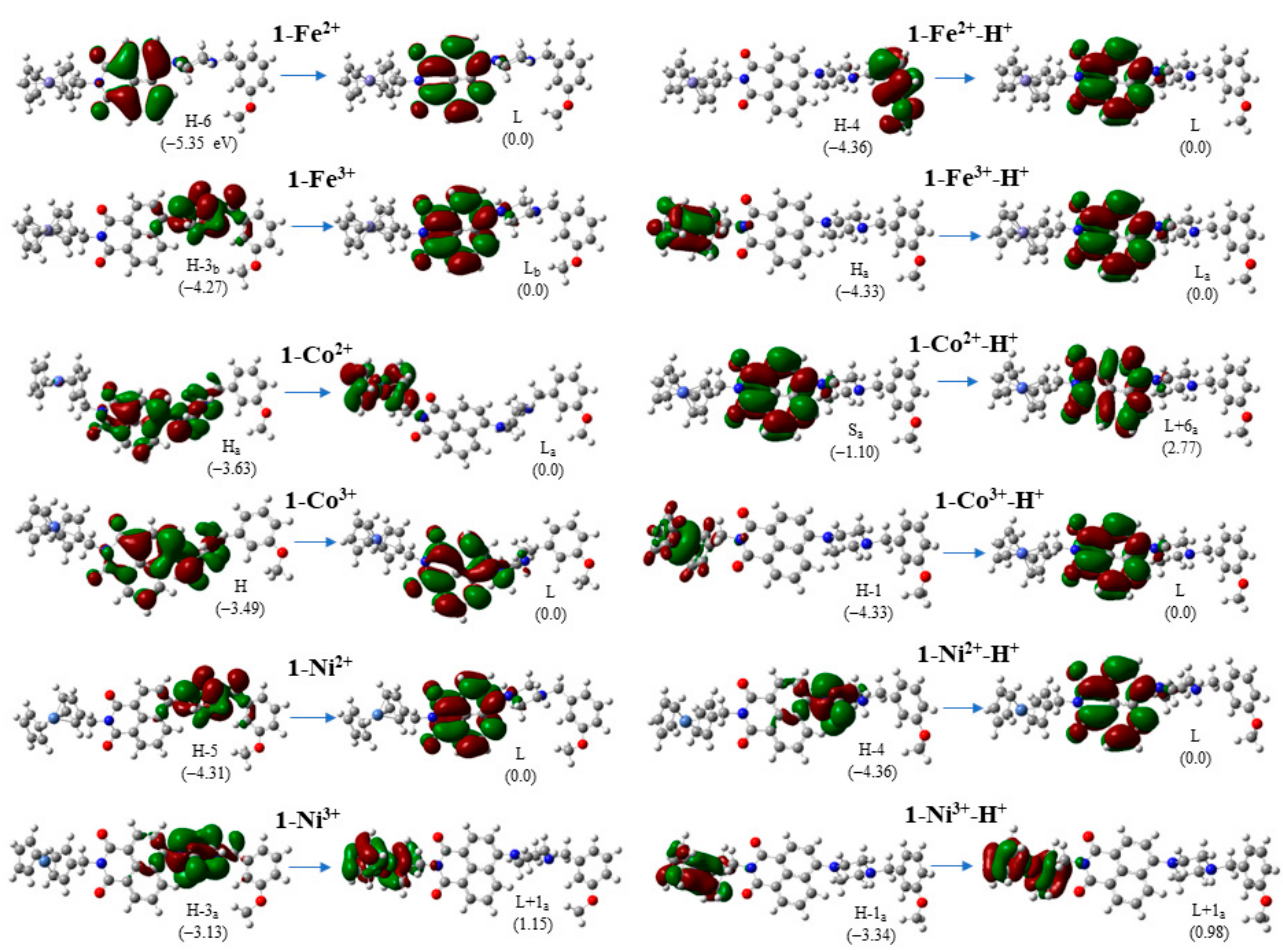
Figure 7. Frontier molecular orbitals of the calculated minima structures involved in the main absorption peaks in visible and near-UV areas (Table 4) at PBE0/6-31G(d,p) in THF solvent. Relative energies of orbitals in eV are included with respect to the L orbital. C atoms: grey balls, H atoms: white, O atoms: red; N atoms: blue, M (Fe, Co,Ni) atoms: violet.